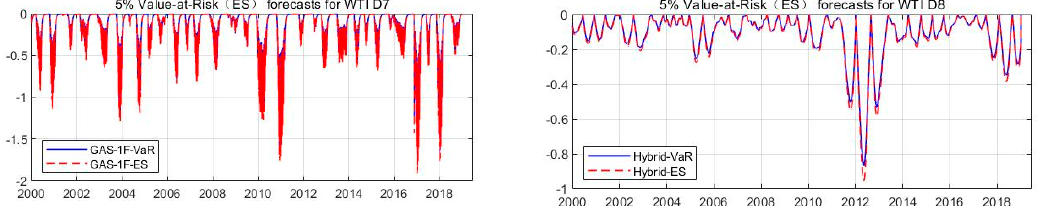
Figure 4. The forecasted 5% VaR and ES values for the wavelet of the WTI crude oil price over the period of January 2000 to December 2018. The estimates are based on the model with the best fit from Table 6.